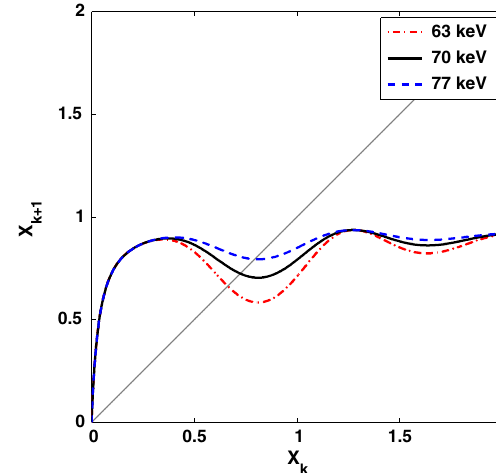
FIG. 4. Normalized intensity at the end of the oscillator as a function of that of the previous pass. Three values of the initial energy spread are considered, with all other pa- rameters held fixed. The diagonal line indicates possible equilibrium points. For the nominal 70 keV case, the slope of the map at the equilibrium point is (cid:2) 0 : 45 . All three cases are